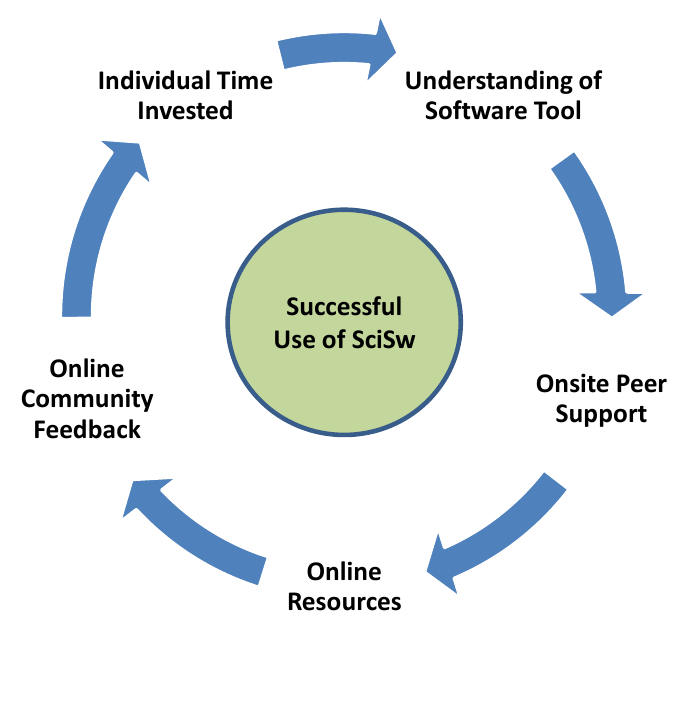
Figure 3. A systematic training cycle for scientific software